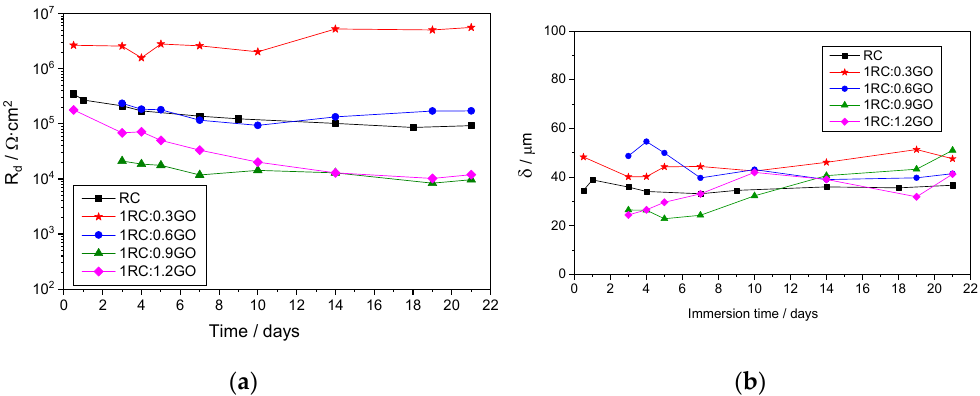
Figure 9. Evolution with the immersion time of ( a ) R d and ( b ) the diffusion length δ.